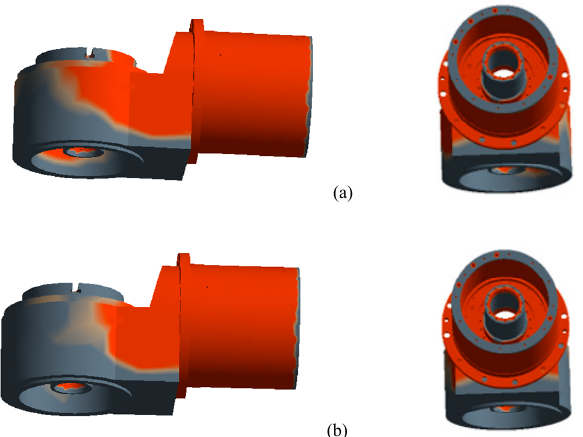
Figure 19. Topology optimization results of direct-drive turntable in milling condition: ( a ) 50% mass retention rate; ( b ) 60% mass retention rate.